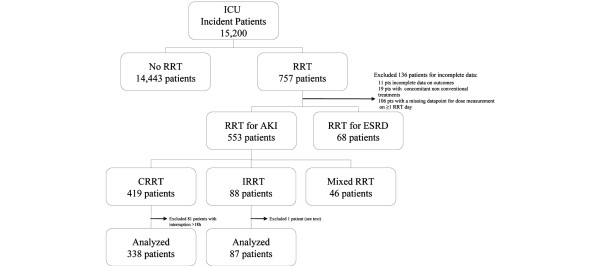
Profile of study population. Calculation of RRT dose was performed on patients who were treated exclusively on one RRT schedule (CRRT only or IRRT only). Forty six patients were treated with mixed RRT schedules (CRRT + CPFA, n = 10; CRRT + IRRT, n = 36; see text for explanation). AKI = acute kidney injury; CKD = chronic kidney disease; CPFA = coupled plasmafiltration adsorption; CRRT = continuous renal replacement therapy; ESRD = end-stage renal disease; ICU = intensive care unit; IRRT = intermittent renal replacement therapy.